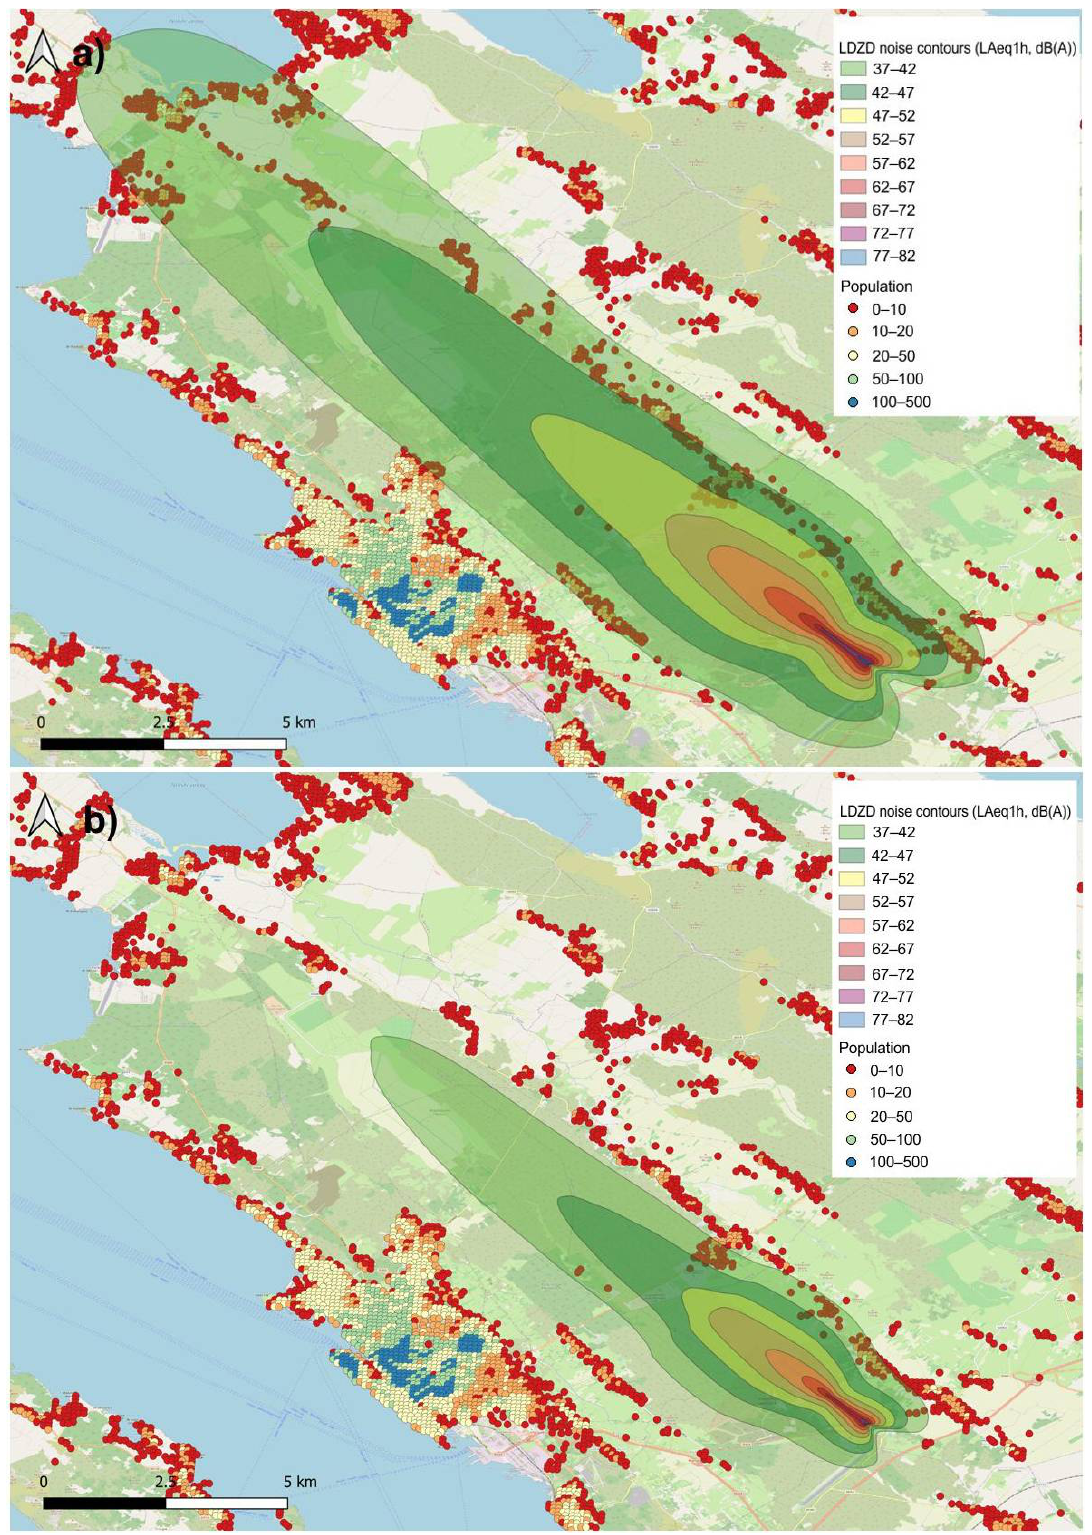
Figure 5. L Aeq ,1h noise contours for Zadar Airport, ( a ) with TAM-related delays and ( b ) without TAM-related delays.